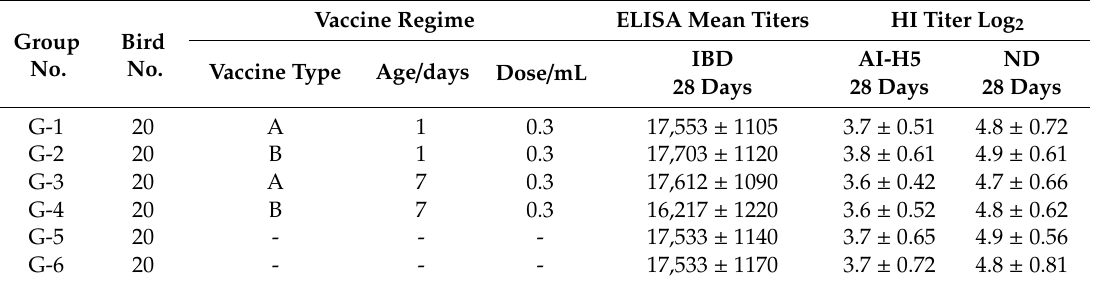
Table 3. Serological response of broiler chickens to infectious bursal disease virus (IBDV), Newcastle disease (ND), and avian influenza-H5N1 (AI-H5) vaccines at 28 days of